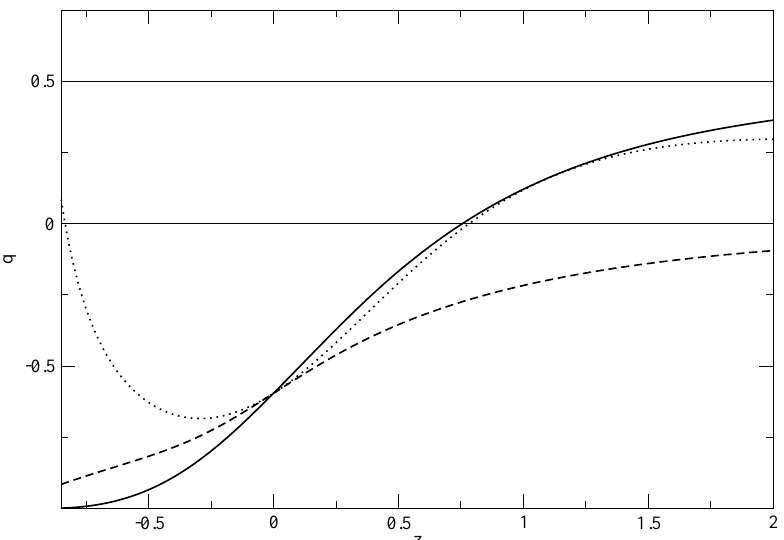
Figure 2. Deceleration parameter for the Λ CDM model (solid line) and for the best fit points of Approaches I (dotted line) and II (dashed line). The q = 0 line marks the transition from the decelerated to accelerated phase, and the q = 0.5 line marks the matter-dominated